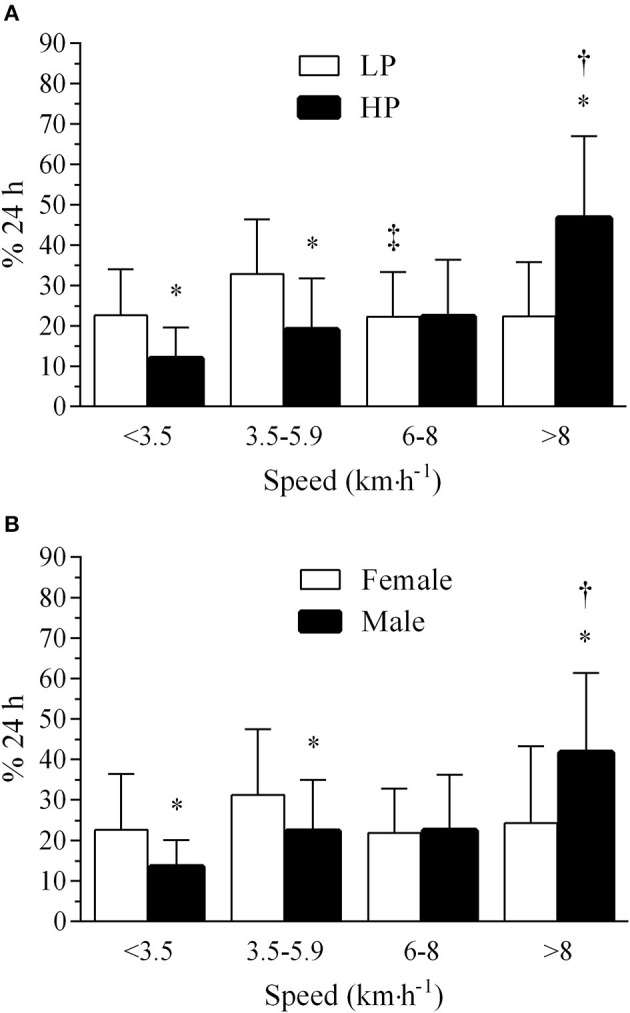
Percentage of time spent at speeds corresponding to a substantial speed reduction (SSR <3.5 km·h−1), walking (from 3.5 to 5.9 km·h−1), walk-to-running transition (from 6.0 to 8.0 km·h−1) and running (>8.0 km·h−1). (A) HP vs. LP; (B) male vs. female; *, significant difference (P < 0.05) between performance levels or sexes in the same speed range; ‡, significant difference (P < 0.05) when compared to 3.5–5.9 km·h−1 LP; †, significant difference (P < 0.05) when compared to lower speed range(s) in the same performance level or sex; LP = low performance; HP, high performance. Results presented in mean and standard deviation.